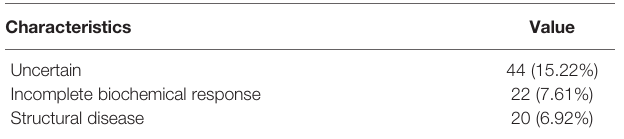
TABLE 1 | Characteristics of the study